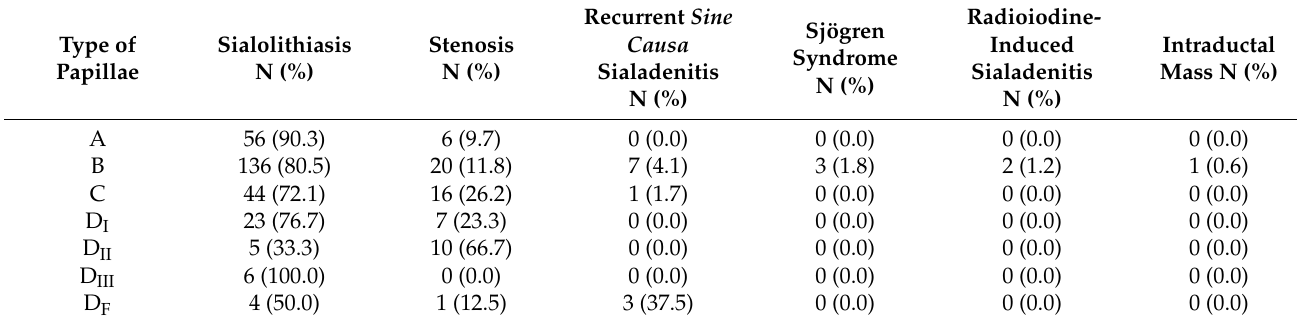
Table 2. Analysis of indications for the